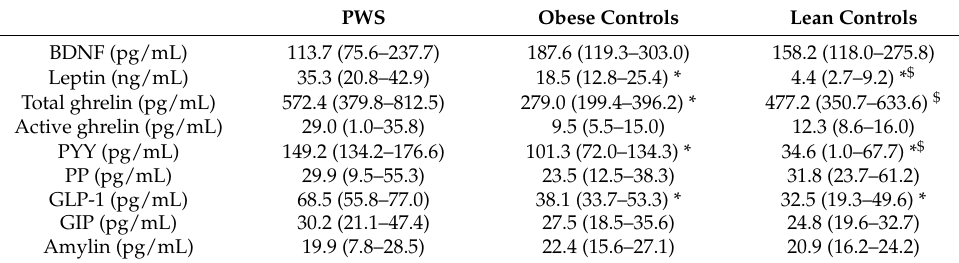
Table 2. Fasting hormonal